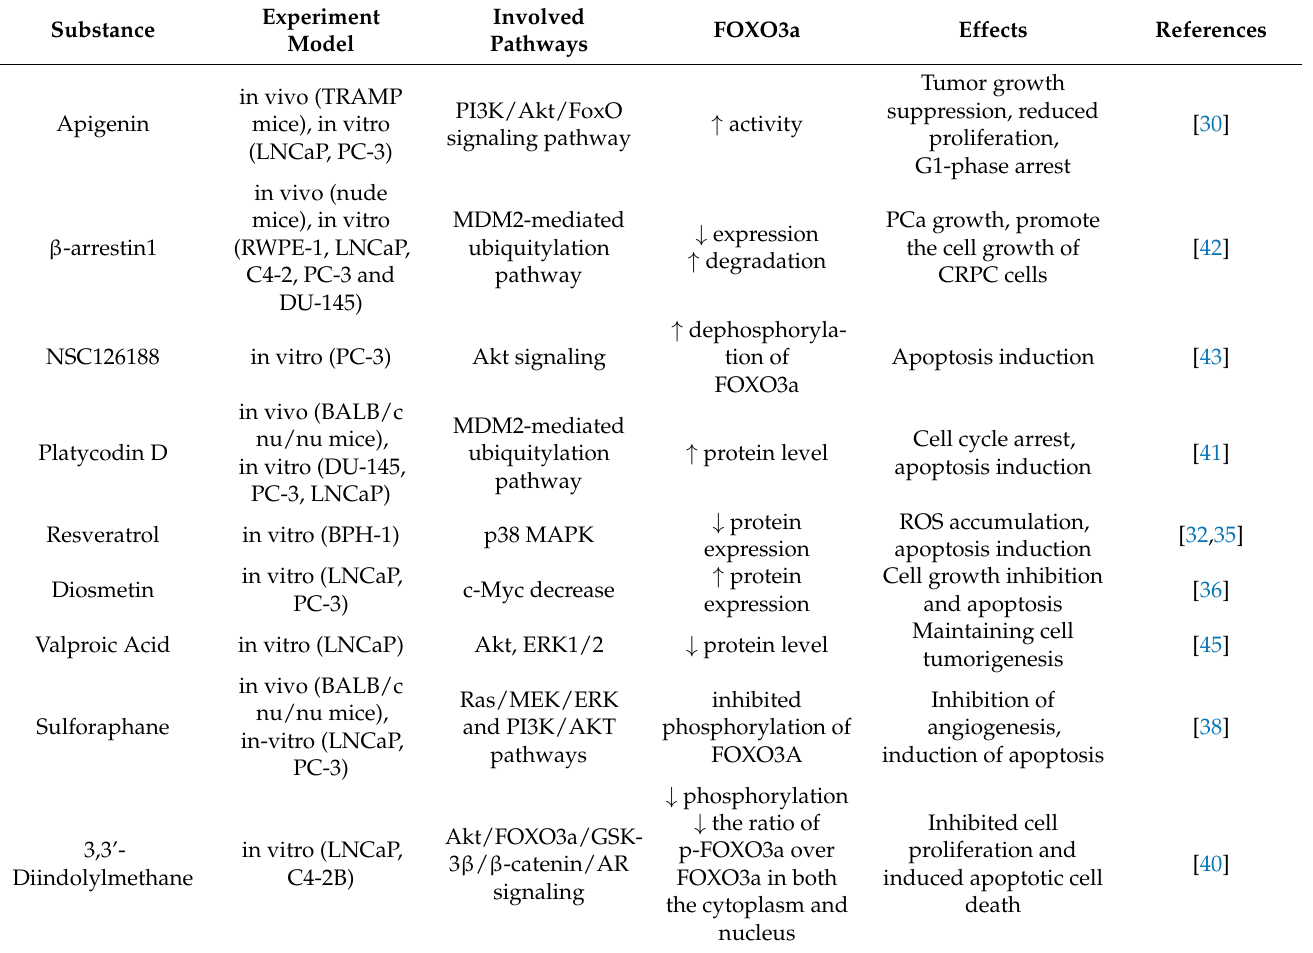
Table 1. Summarized information related to compounds that regulate FOXO3a